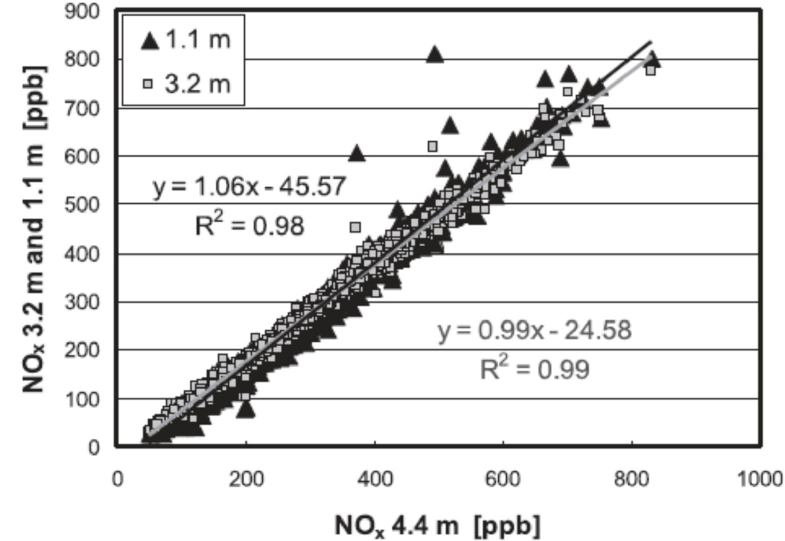
Figure 54. Plot of NO x concentration (10-min averages) monitored at 1.1 m and 3.2 m above the ground surface against the corresponding data at the tunnel ceiling (4.4 m); data recorded at Site 2 (downwind;